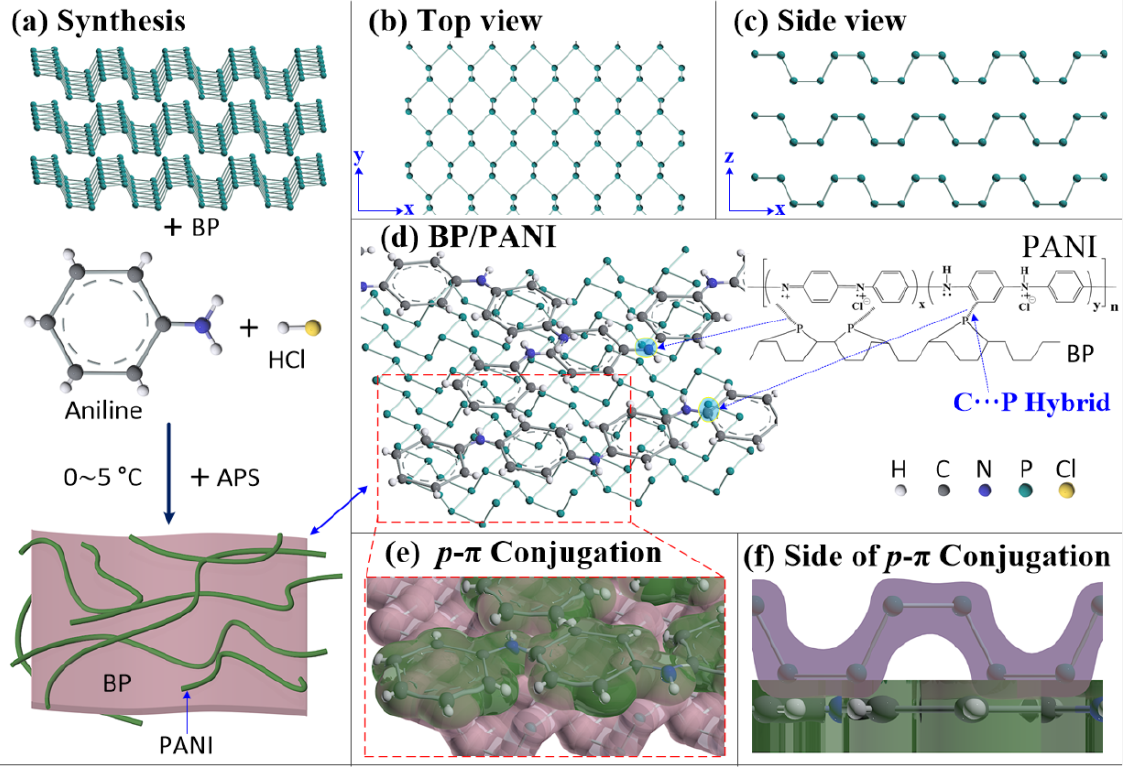
Figure 6. Schematic illustration for ( a – c ) atomic structure of BP, ( a ) polymerization of PANI or BP/PANI, ( d ) C ⋯ P hybrid of BP/PANI, and ( e , f ) p- π conjugation system (this is exaggerated for illustration purposes).